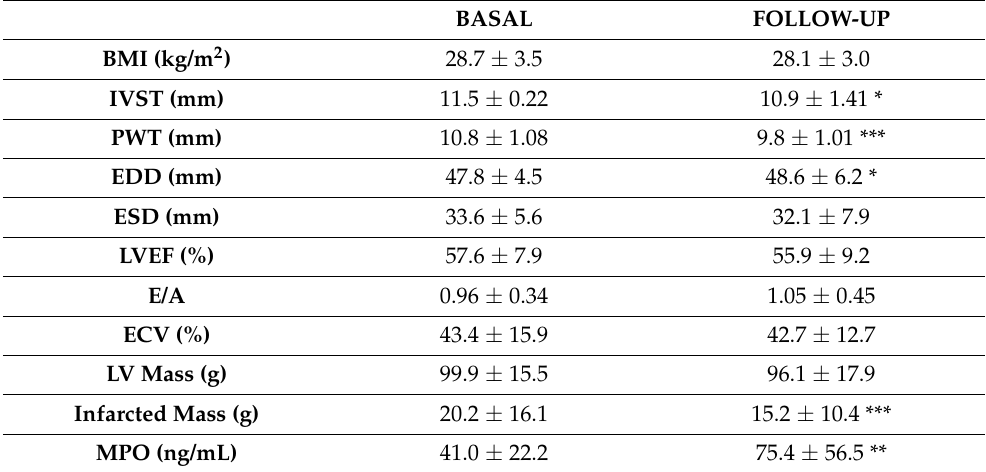
Figure 4. Mitochondrial oxidative stress mediates the cardiac activation of endoplasmic reticulum stress in infarcted rats. Protein levels of ( A ) immunoglobin binding protein (BiP); ( B ) activating transcription factor 6 alpha (ATF6 α ); ( C ) CCAAT-enhancer-binding protein homologous protein (CHOP); ( D ) activating transcription factor 4 (ATF4); ( E ) calpain 1; and ( F ) calreticulin (CALRT) in cardiac tissue from control rats (CT) and rats submitted to myocardial infarction treated with vehicle (MI) or with the mitochondrial antioxidant MitoQ (MI-MQ; 50 mg/kg/day). Bars graphs represent the means ± SD of 8–10 animals, normalized for glyceraldehyde 3-phosphate dehydrogenase (GAPDH). ** p < 0.01, *** p < 0.001 vs. CT group. † p < 0.05, †† p < 0.01, ††† p < 0.001 vs. MI group. Table 1. Cardiac function, body mass index, and circulating MPO levels in MI patients in basal conditions and 12-month